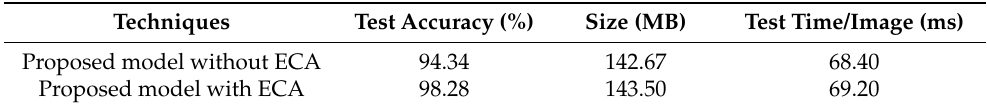
Table 5. Model experiment accuracy with or without